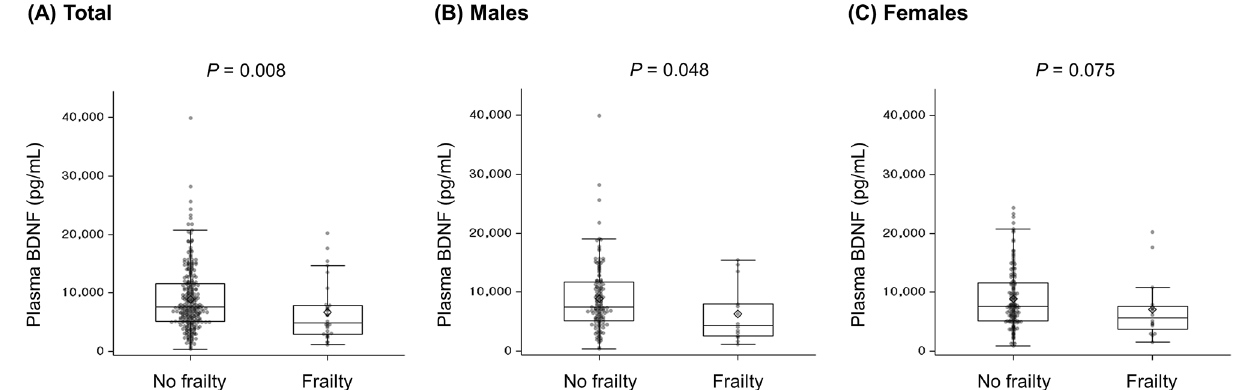
Figure 1. Plasma brain-derived neurotrophic factor levels according to the presence of frailty in total participants ( A ), males ( B ), and females ( C